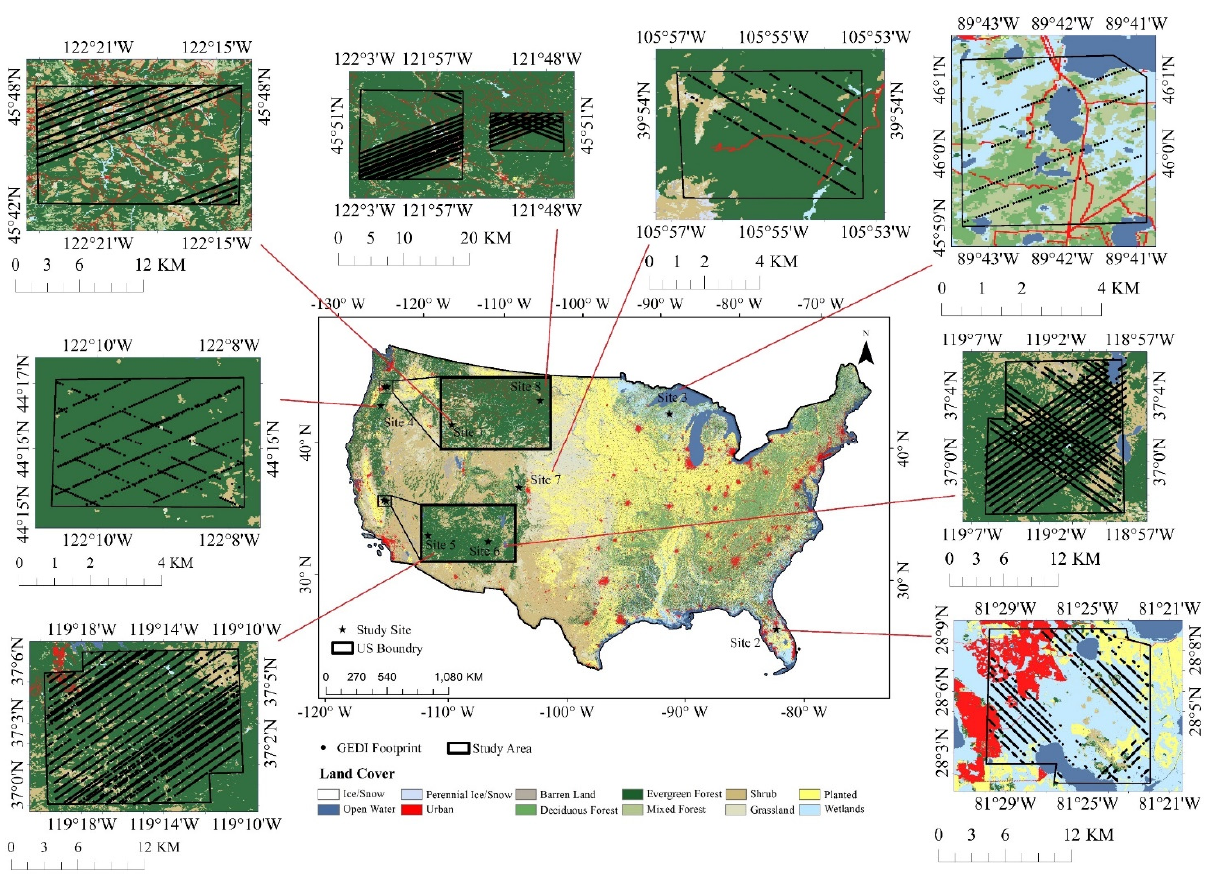
Figure 2. The study sites’ (marked with black stars) distribution in this study. The background in the pictures is the 2019 land cover product from the National Land Cover Database (NLCD) [30] with a 12-class legend. Table 1. Airborne laser scanning (ALS) sites in the study.